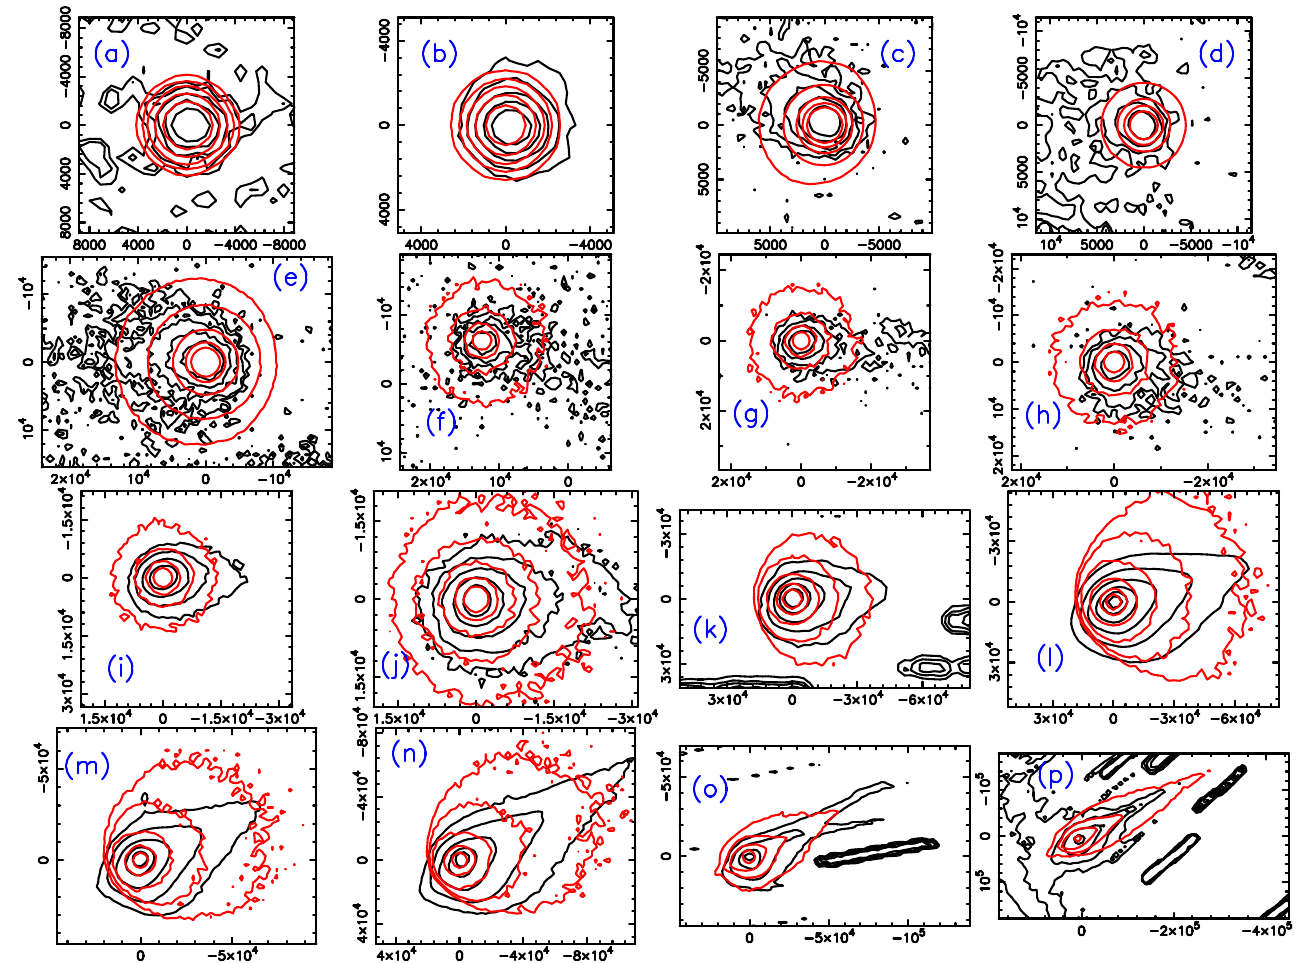
Figure 4. Isophote fields of a subset of observed (black contours) and modeled images (red contours) at different heliocentric distances (in au), as follows: ( a ) − 4.33; ( b ) − 3.80; ( c ) − 3.54; ( d ) − 3.20; ( e ) − 2.95; ( f ) − 1.51; ( g ) − 1.42; ( h ) − 1.37; ( i ) − 1.27; ( j ) − 1.25; ( k ) +1.25; ( l ) +1.30; ( m ) +1.47; ( n ) +1.62; ( o ) +2.69; ( p ) +3.14. Negative distances indicate pre-perihelion, positive post-perihelion branch. The x- and y-axes are all labelled in km projected at the comet distance. All images are shown in the conventional north-up and east-to-the-left orientation. Adapted from